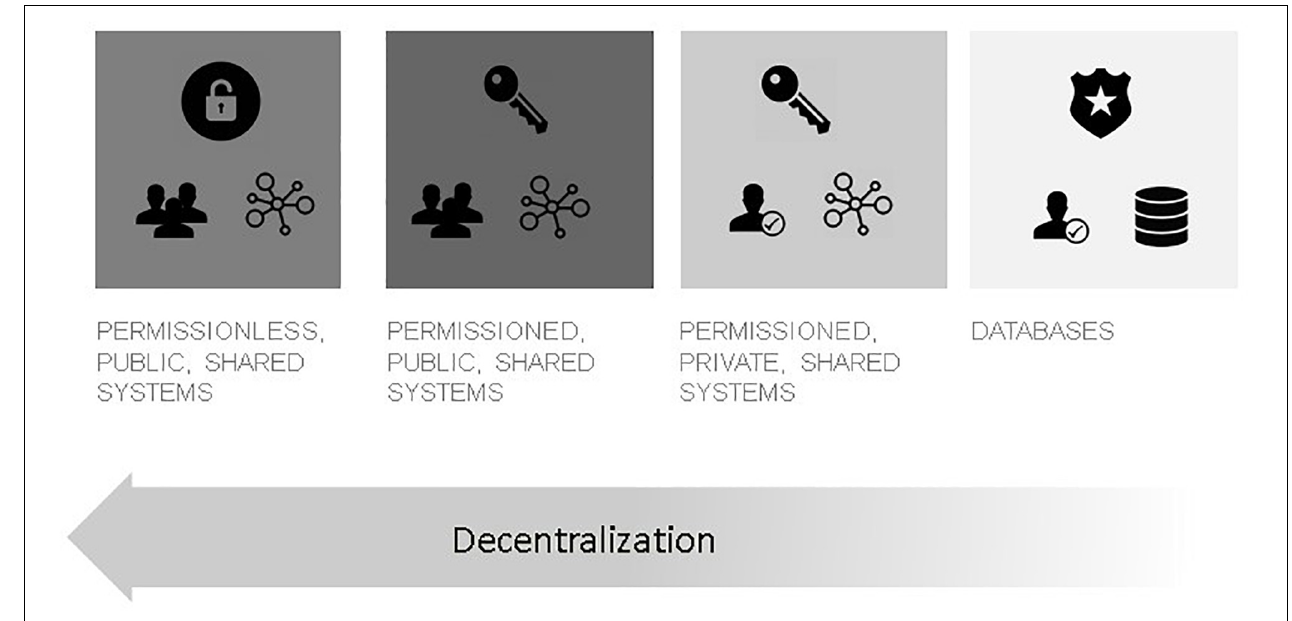
FIGURE 1 | Types of blockchains and